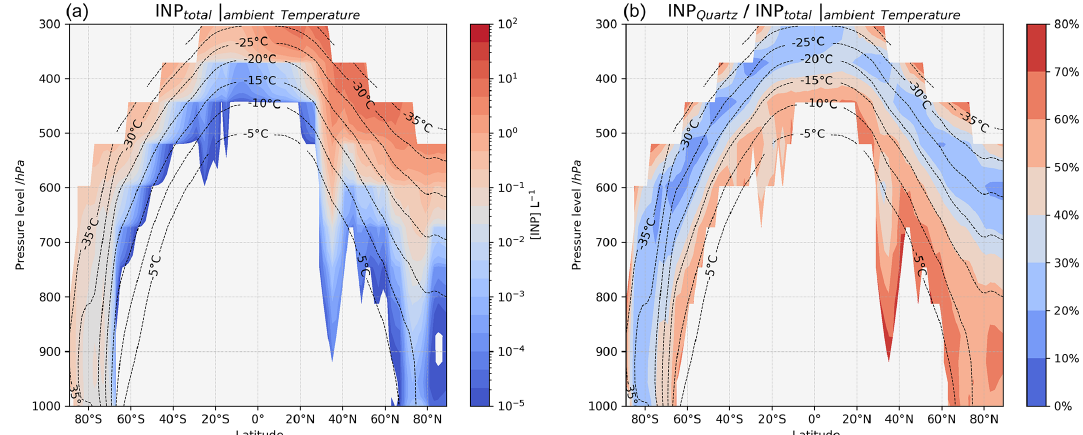
Figure 8. Annual zonal-mean profiles of [INP] ambient number concentration for 2015, calculated by TM4-ECPL and accounting for K- feldspar and quartz. The black contour dashed lines show the annual mean temperature of the model. The color map shows the INP concen- tration derived from feldspar and quartz dust aerosols [INP] total (a) and the ratio of INPs from quartz to the total INPs from both minerals (b)